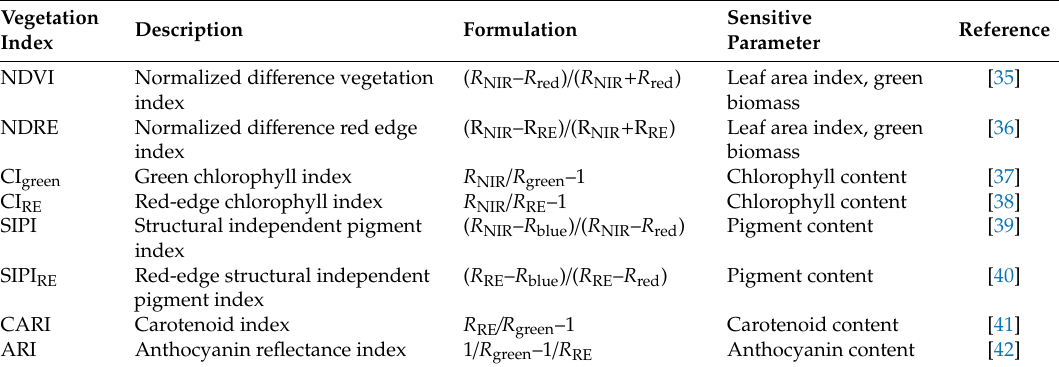
Table 1. List of eight vegetation indices (Vis) used in this